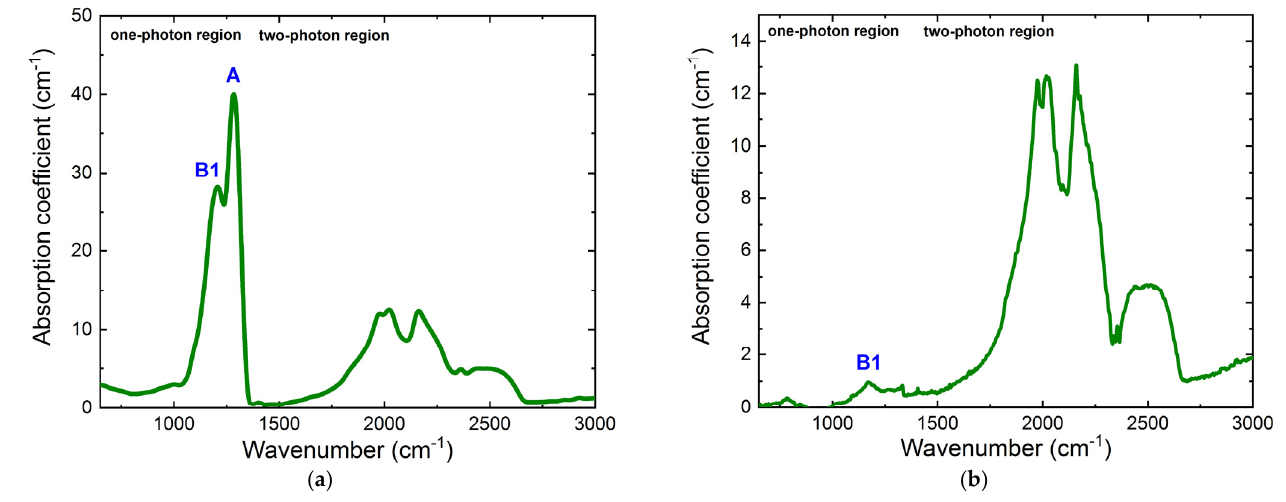
Figure 2. FT-IR spectra of natural diamonds: ( a ) IaAB (1784-8-1); ( b ) IaB (EV-8-5). Table 1. Content of different nitrogen impurity defects in IaAB and IaB diamonds.